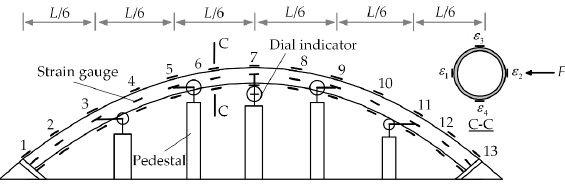
Figure 2. The measuring scheme of the arch model.